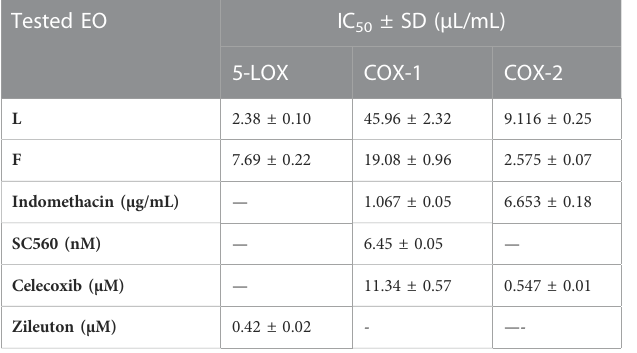
TABLE 3 IC 50 of P. cattleianum leaves (L) and fl owers ’ (F) essential oils against 5- LOX, COX-1, and COX-2 enzymatic activities. Tested EO